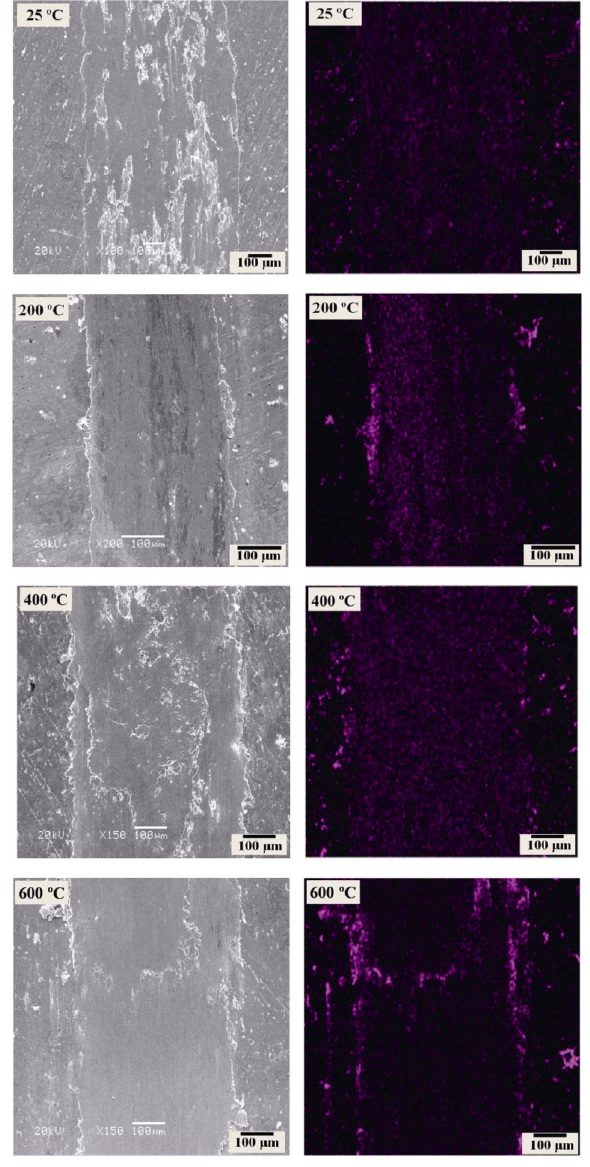
Fig. 11 SEM images of the worn surfaces of composite G2 and corresponding Ag element distribution maps from RT to 600